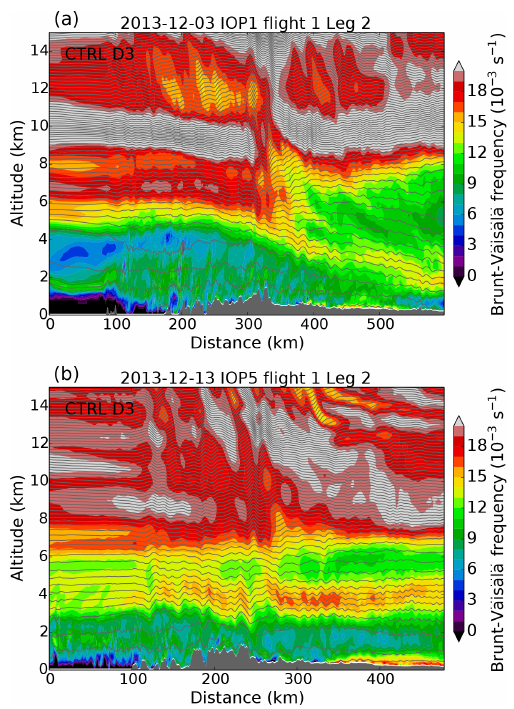
Figure 6. Cross sections of CTRL D3 Brunt–Väisälä frequency (coloured contours) of flight 1, leg 2, during (a) IOP1 and (b) IOP5. Potential temperature is indicated with black contour